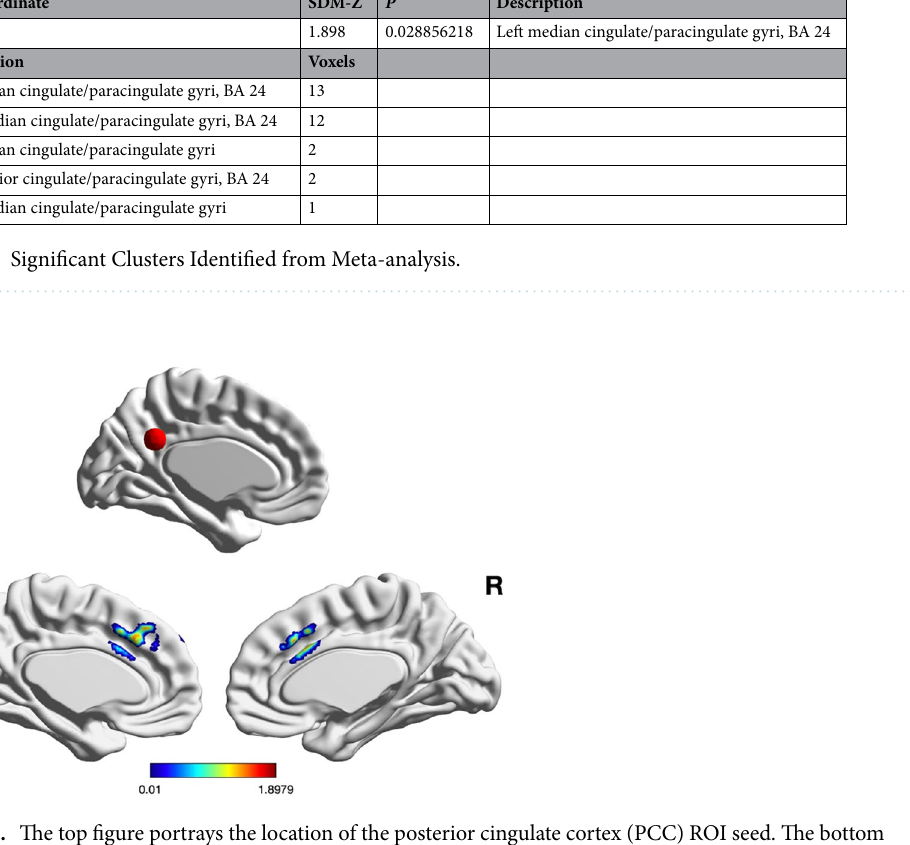
Figure 1. The top figure portrays the location of the posterior cingulate cortex (PCC) ROI seed. The bottom figures show a 3D map of voxelwise z-scores, with significant cluster effects localized to the left dorsal anterior cingulate cortex (dACC) (BA 24).